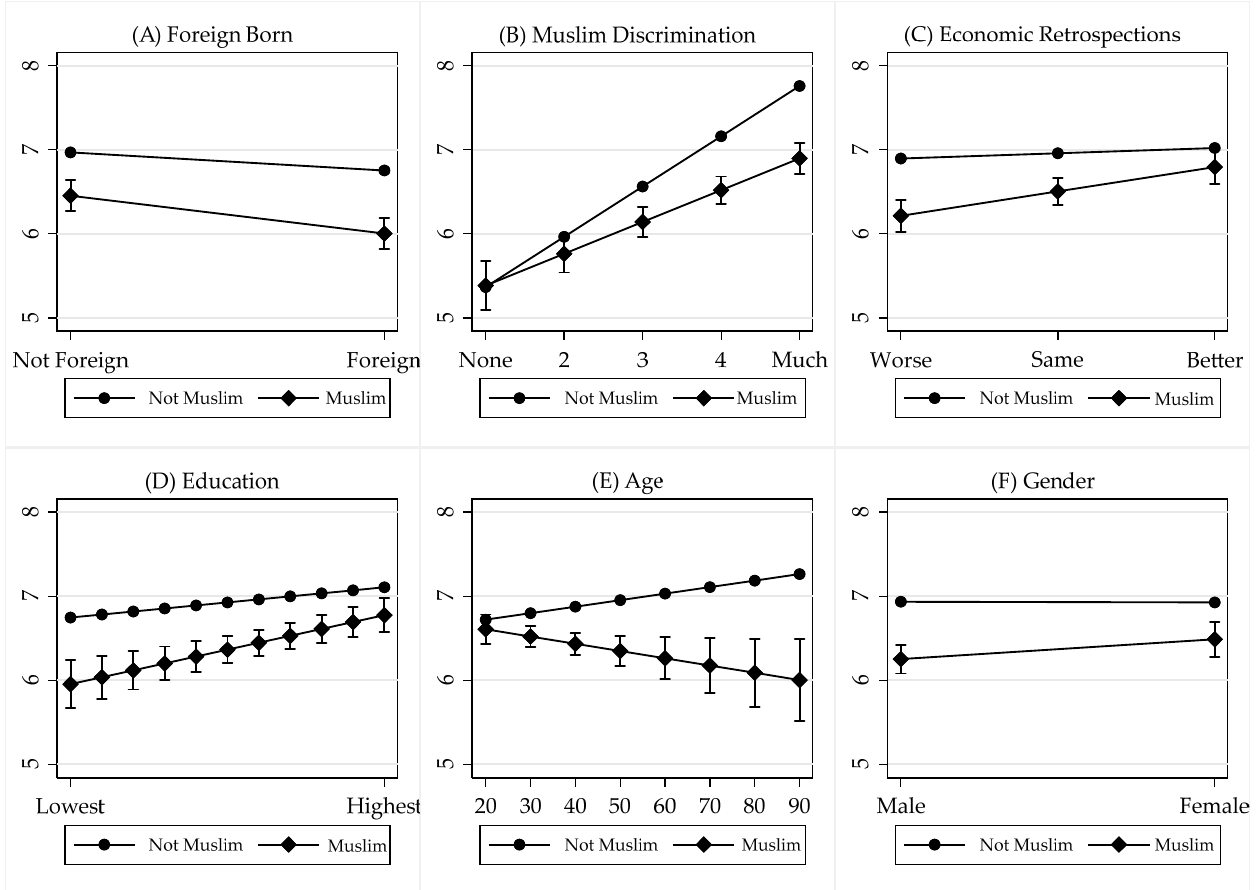
Figure 2. Factors Affecting Variation in Muslim Attitudes toward Jews. Source: Nationscape, based on results from Table 1, Model 2. Each cell represents the impact of a specific variable on the Antisemitism Index. The left axis indicates the predicted Antisemitism Index score based on each variable’s values, with all other variables held at their means. The lines (slopes) with the black circles are the regression lines for non ‐ Muslims, and the lines with the black diamonds are for Muslims. Panel 2A graphs the impact of being foreign born on Muslims and non ‐ Muslims. The horizontal axis on the graph is for foreign born versus non ‐ foreign ‐ born. The vertical axis, with numbers running from 5 through 8, is the level of antisemitism on the index, which can range from 1 to 10. There are two lines, one with circles for non ‐ Muslims and the other with diamonds for Muslims. The other graphs can be read similarly, except that the hori ‐ zontal variable changes. The plot shows that both foreign ‐ born respondents’ attitudes toward Jews are less positive than non ‐ foreign born (native ‐ born) respondents, with similar slopes (the angle of the lines) for Muslims and non ‐ Muslims. For non ‐ Muslims, the predicted antisemitism